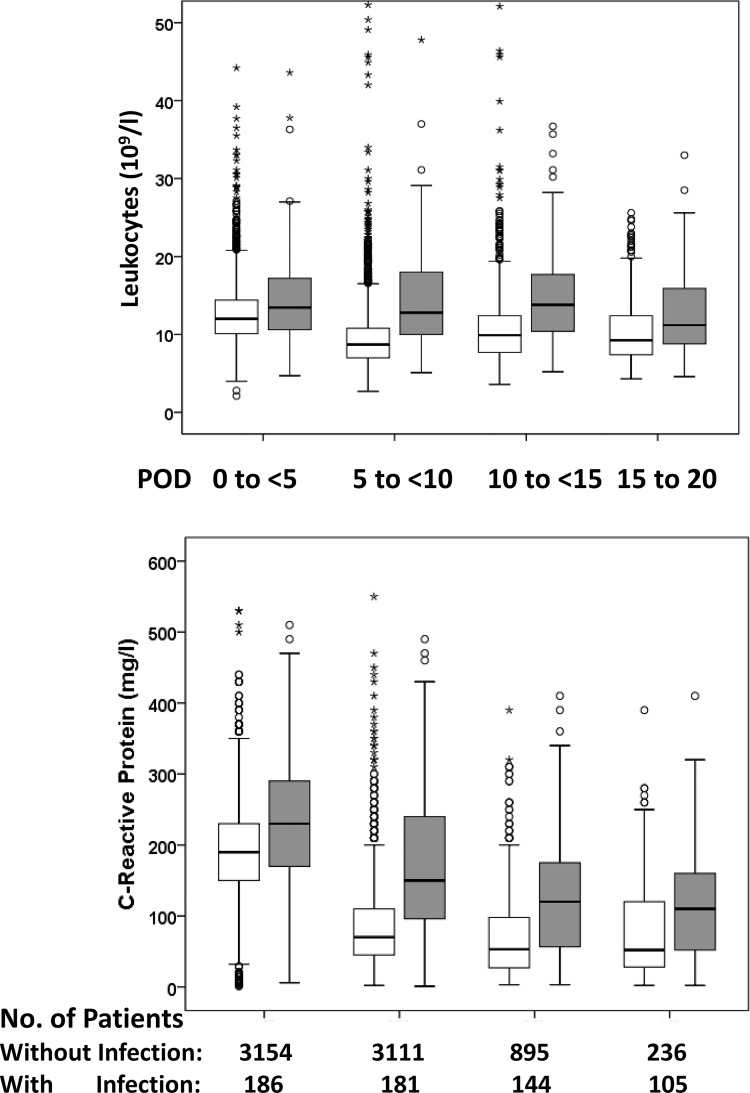
Postoperative time course of leukocyte and C-reactive protein concentrations in cardiac surgical patients with and without infection.The boxes express the upper and lower quartiles, and the central lines show the median. The whiskers represent the values below and above the interquartiles. The circles illustrate outliers, and the stars denote extremes. white boxes, patients without infection; grey boxes, patients with infection; POD, postoperative day